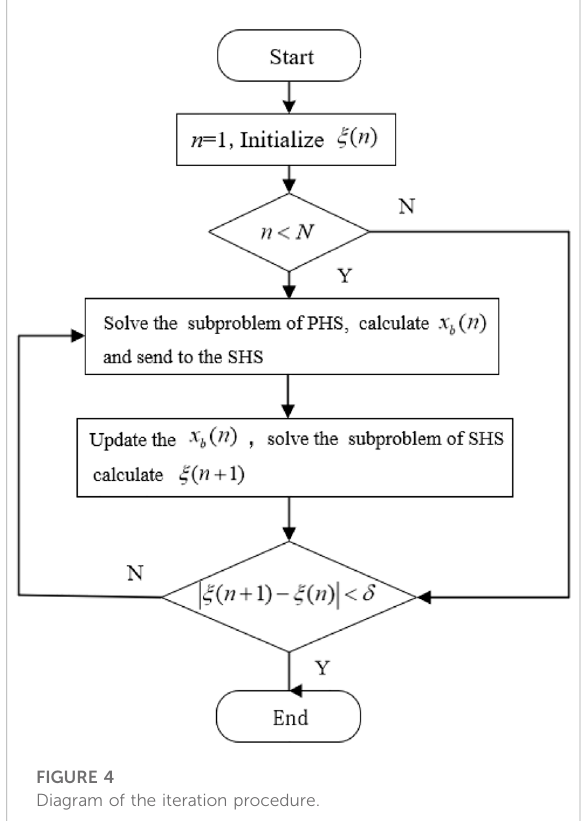
FIGURE 4 Diagram of the iteration